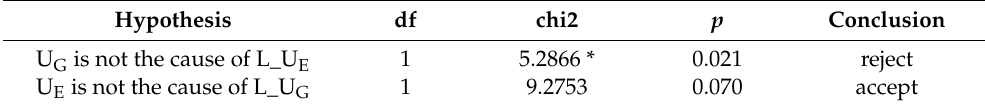
Table 7. Results of Granger causality test.